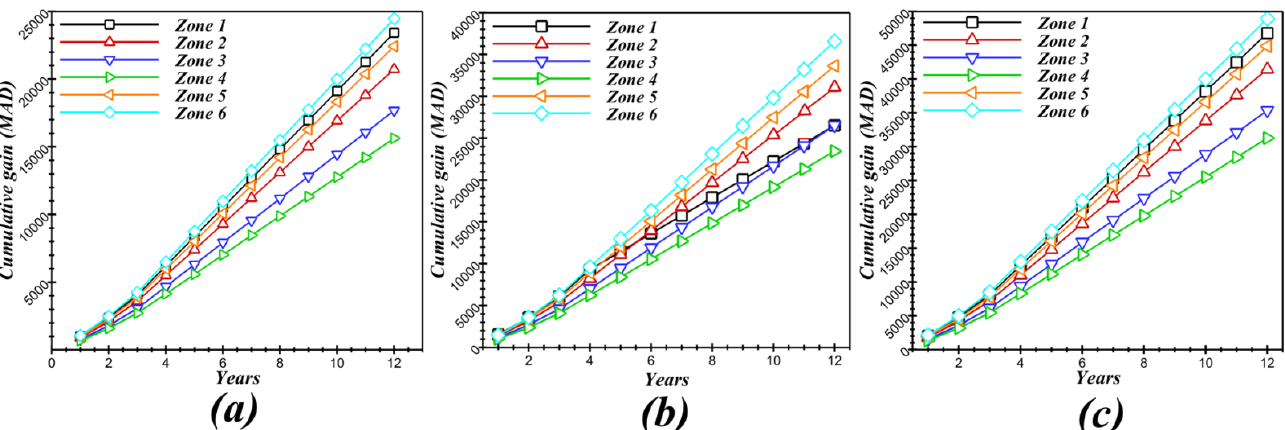
Figure 15. ( a ) Cumulative gains for buildings (non-subsidies scenario). ( b ) Cumulative gains for modern Moroccan houses (non-subsidies scenario). ( c ) Cumulative gains for villas (non-subsidies scenario).